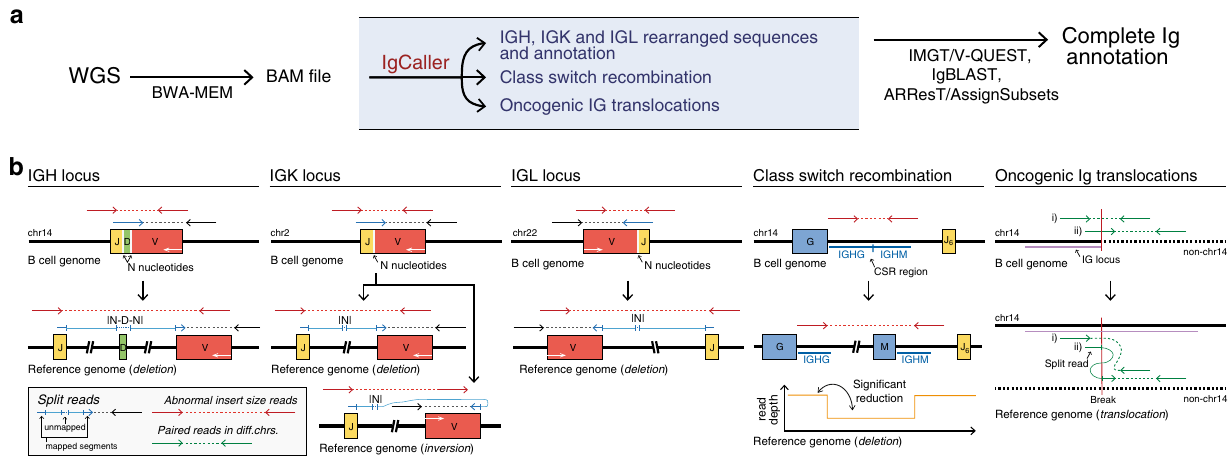
Fig. 1 Overview of IgCaller and Ig loci at short-read WGS level. a Bioinformatic steps to fully characterize the rearranged Ig gene from short-read WGS data. IgCaller extracts the rearranged sequences from already aligned reads (BAM fi le). The output of IgCaller might be used as input to downstream speci fi c programs for a complete Ig annotation. b Schema of the Ig loci at B cell genome level (top) and reference genome level (bottom) for the different loci/rearrangements analyzed by IgCaller. Of note, although the IGK locus is oriented on the negative strand, the IGKV4-1, IGKV5-2, and IGKV genes within the distal cluster are inverted and therefore oriented on the positive strand. Thus, rearrangements involving these IGKV genes are formed through inversions rather than deletions. The WGS reads that cover the rearrangements and are used by IgCaller are depicted in each scenario. White arrows represent the coding